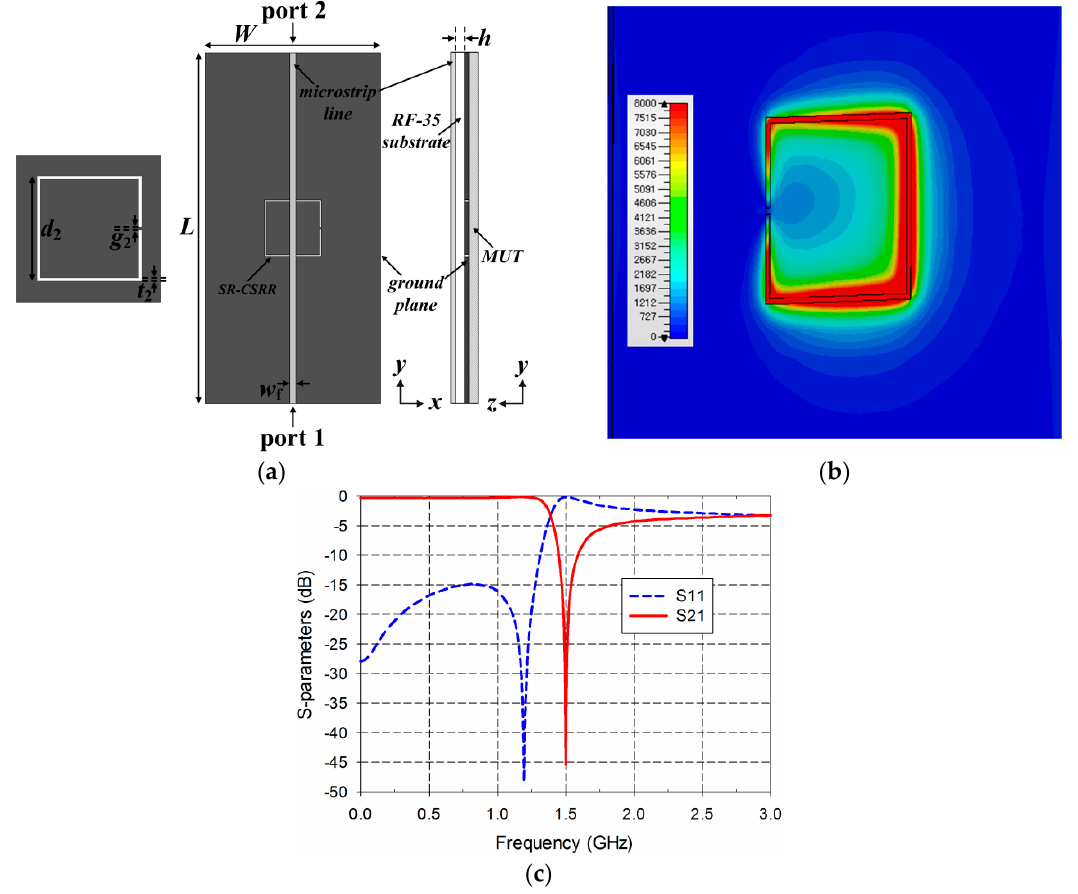
Figure 3. SR-CSRR-based permittivity sensor: ( a ) structure; ( b ) electric-field distribution at 1.5 GHz; ( c ) S-parameter characteristics.